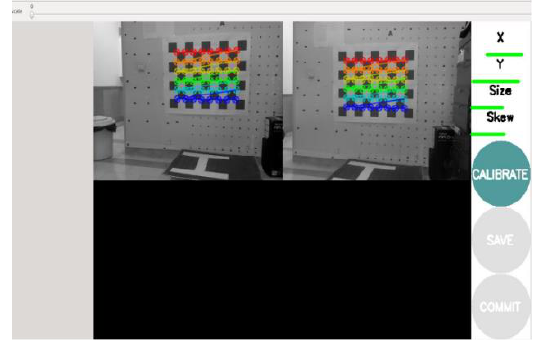
Figure 4. Calibration in laboratory